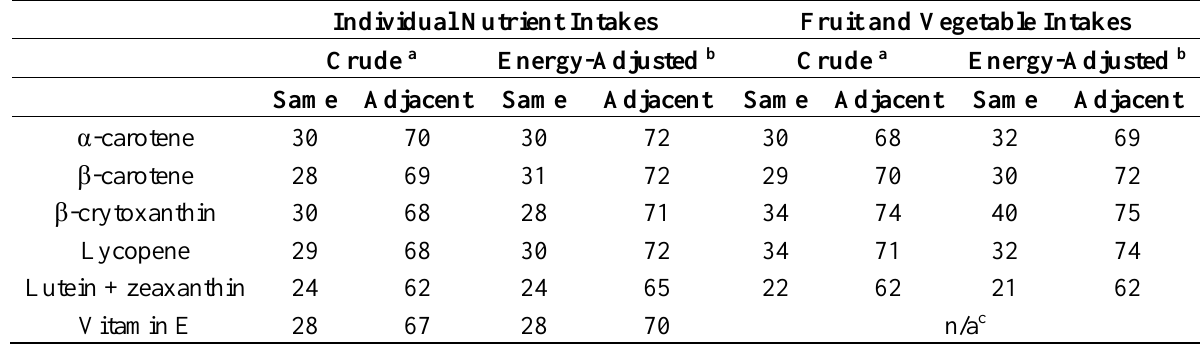
Table 3. Agreement (%) between quartiles of FFQ estimated intakes and